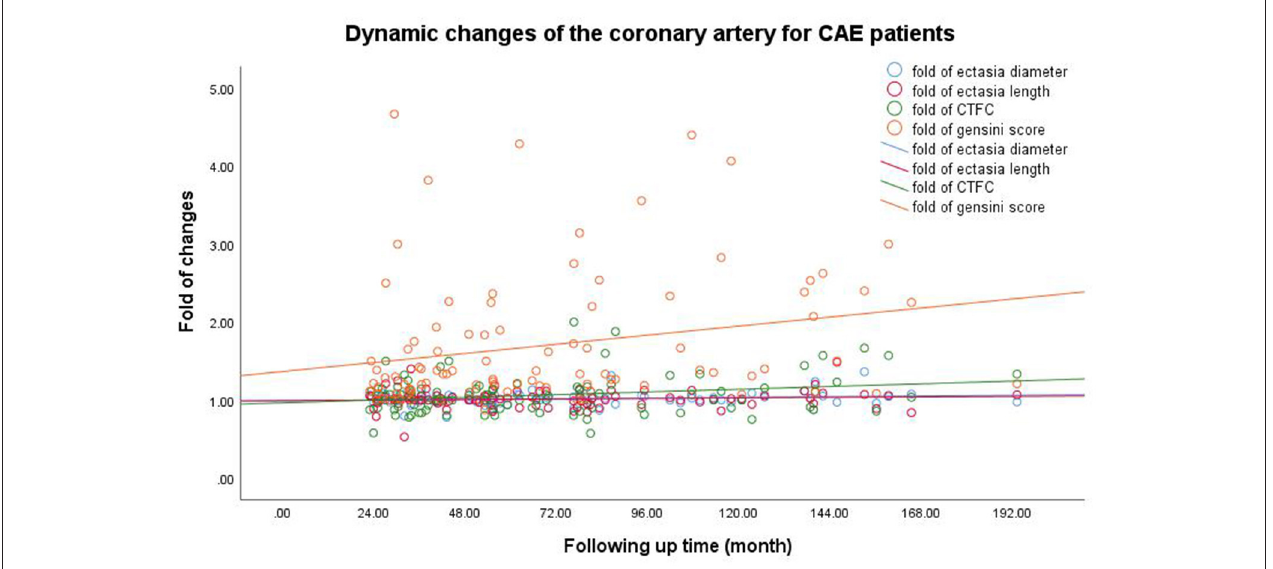
FIGURE 1 | Dynamic changes of coronary artery for CAE patients. The Pearson correlation coefficients ( p -values) for the relationship between follow-up time and the ectasia diameter, length, and extent and the Gensini scores were 0.138 (0.172), 0.053 (0.601), 0.201 (0.046), and 0.237 (0.021), respectively. CAE, coronary artery ectasia; CTFC, corrected thrombolysis in myocardial infarction frame